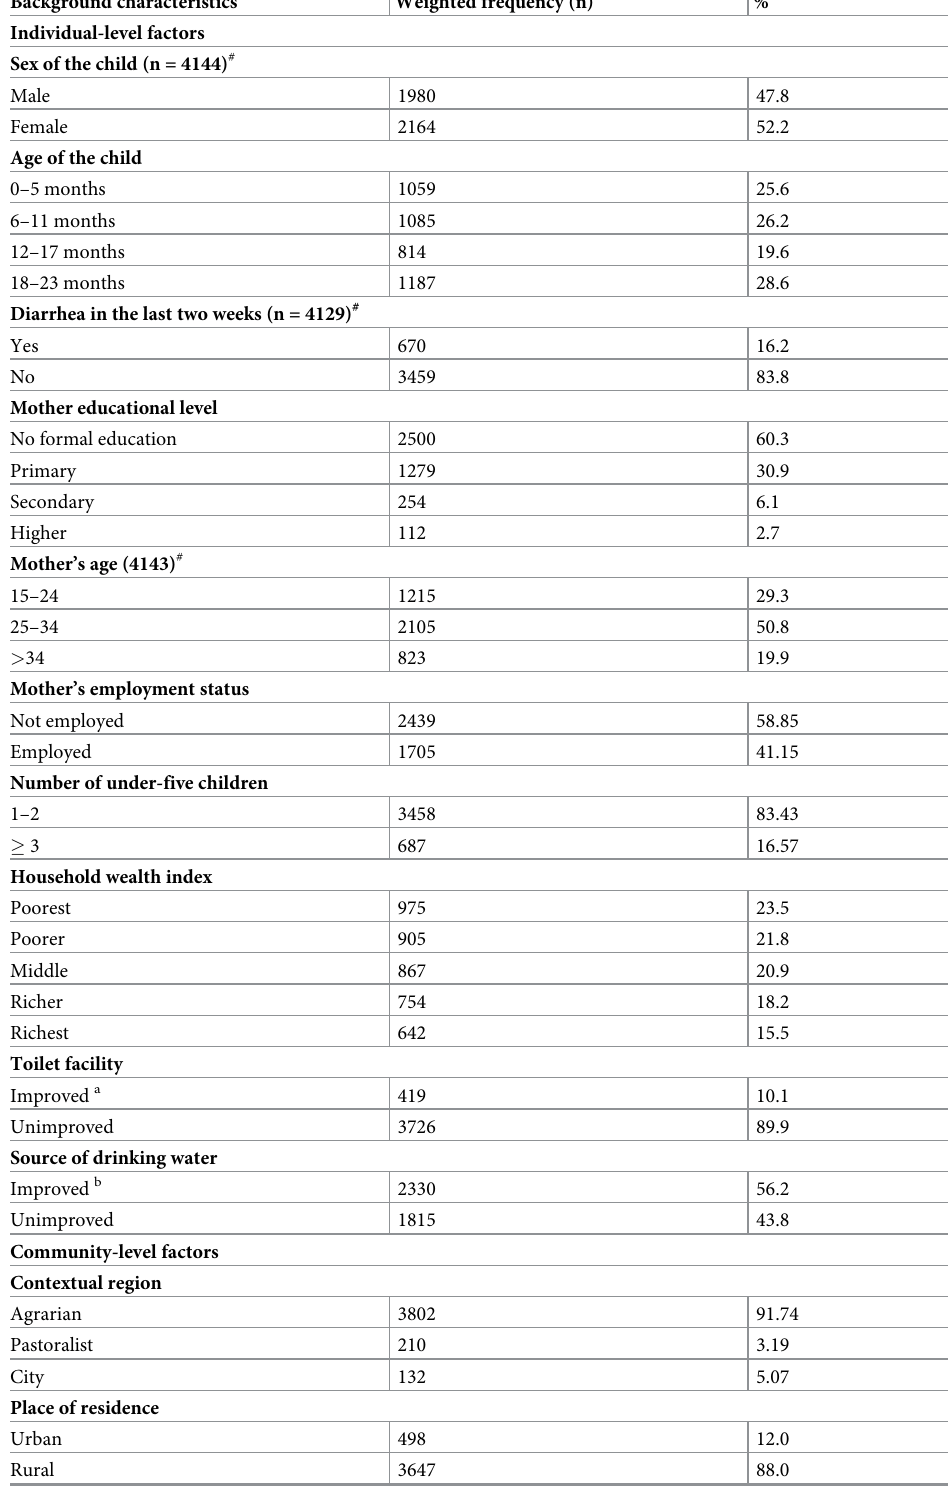
Table 2. Socio-demographic and socio-economic characteristics of study participants, EDHS 2016 (N =